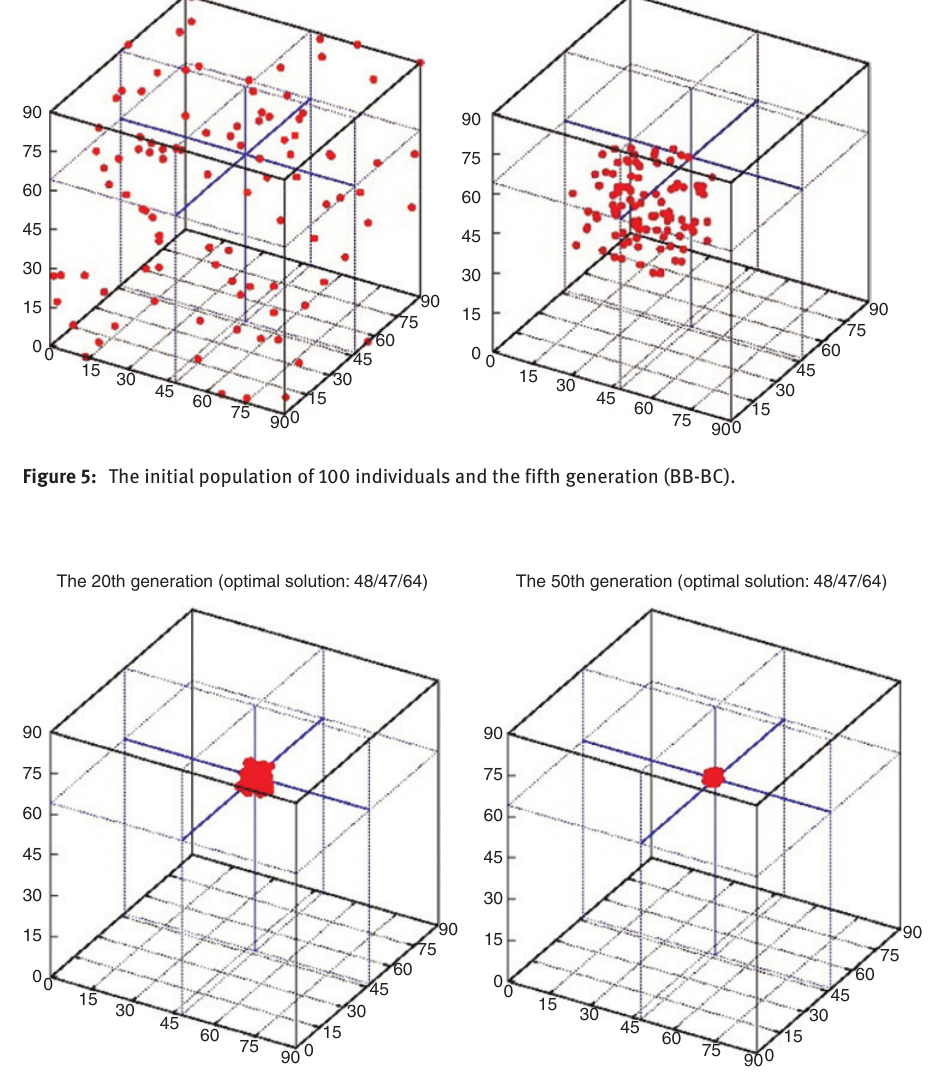
Figure 6: The 20th and 50th generations